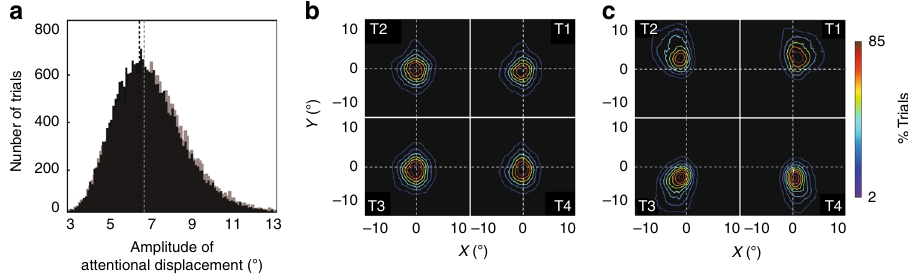
Fig. 9 Attentional spotlight exploration is an endogenous process affected by task events. a Distribution of amplitude of attentional displacement between one PFC attentional position and the next, in the pre-cue period (black) and in the cue-to-target interval (gray). PreCue ( b ) and postCue ( c ) heat maps of the spatial distribution of the decoded attentional